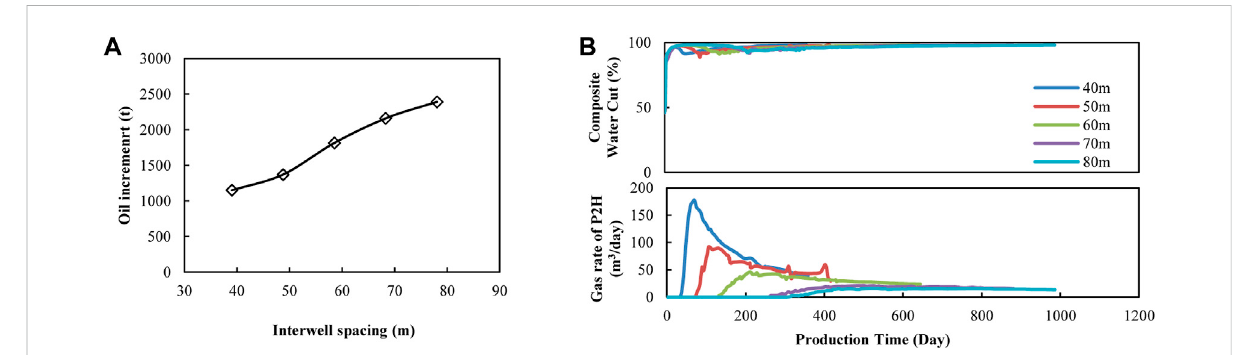
FIGURE 14 Production performance of different interwell spacings for the well-to-well interplay of CO 2 huff-n-puff. (A) Oil increase vs . interwell spacing. (B) Composite water cut and production gas rate vs . time.